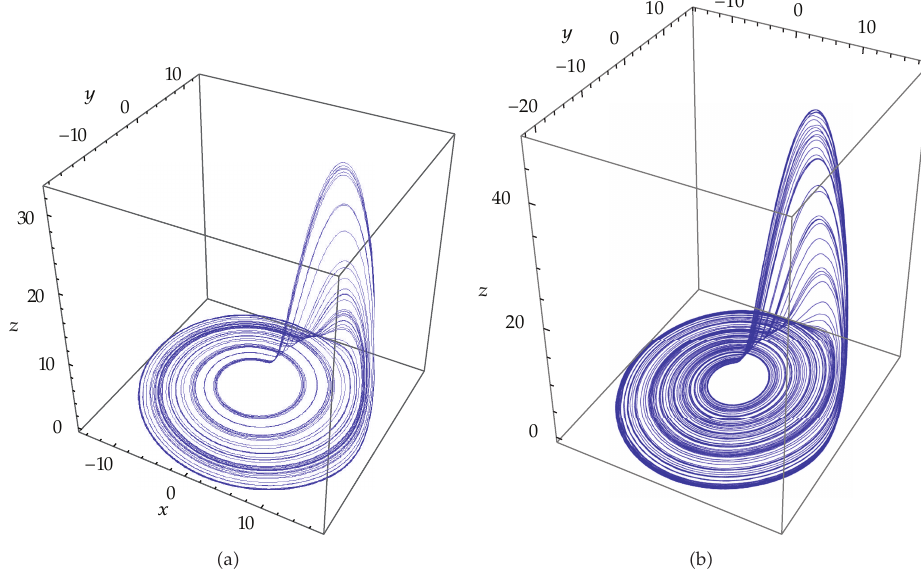
Figure 3: Phase plot of chaotic attractor in the x - y - z space, with a (cid:8) 0 . 15 , b (cid:8) 0 . 2 , c (cid:8) 10: (cid:3) a (cid:4) α 1 (cid:8) α 2 (cid:8) α (cid:8) 0 . 9, (cid:3) b (cid:4) α (cid:8) 0 . 8 , α (cid:8) 0 . 7 , α (cid:8) 0 . 8. 3 1 2 3